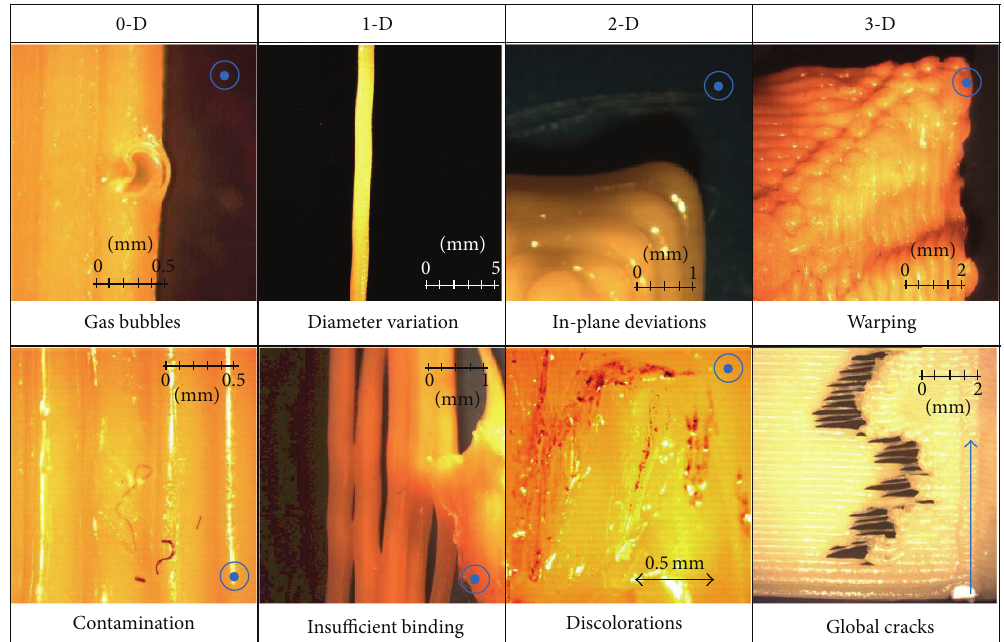
Figure 5: Classification examples for FLM monolayer defects (blue: build